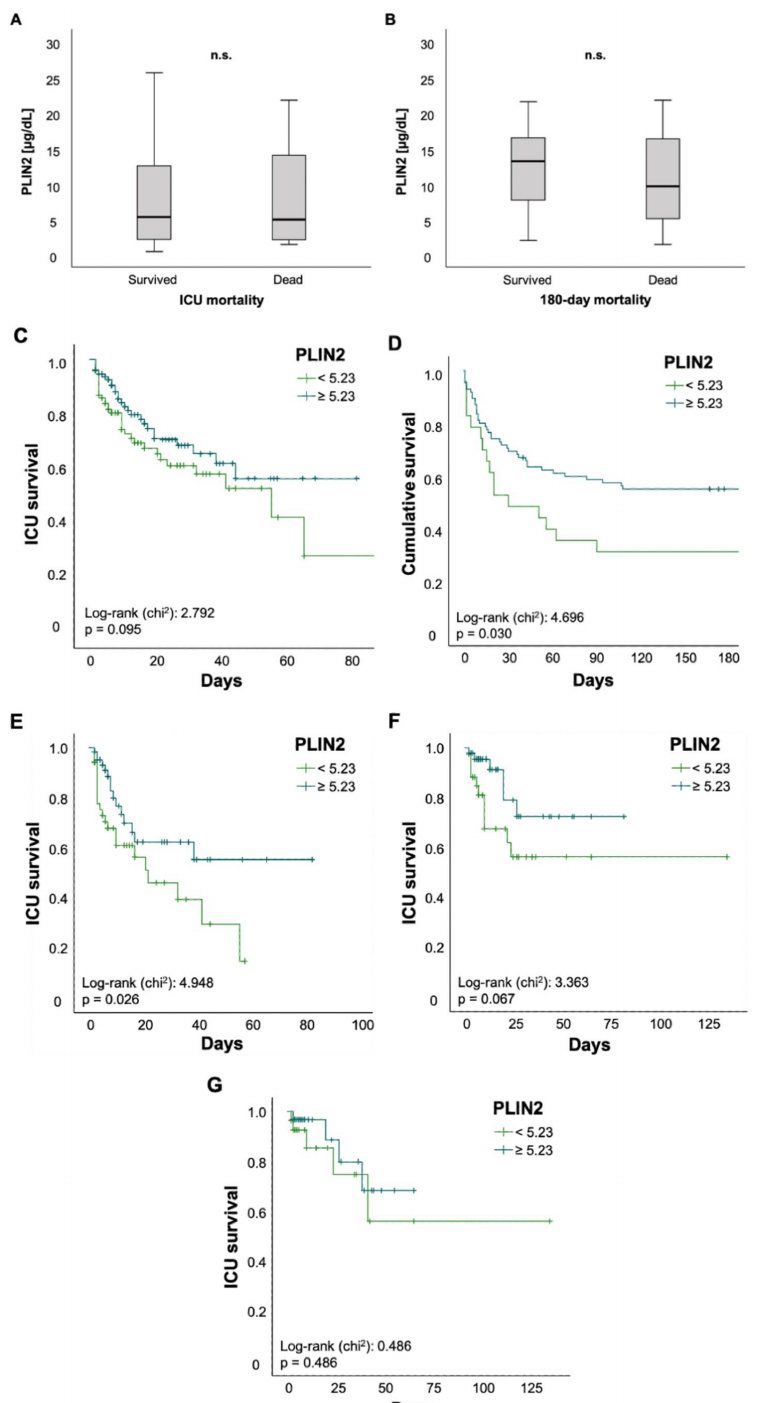
Figure 4. Serum concentrations of PLIN2 may predict ICU mortality in patients older than 65 years. ( A – G ) Neither total ICU- nor 180-day mortality was associated with significant changes in PLIN2 levels ( A , B ). Kaplan–Meier curve analysis showed a trend towards significancy for ICU mortality ( C ), whereas 180 day mortality was significant ( D ). Subgroup analysis revealed that reduced PLIN2 levels in patients older than 65 years may predict ICU mortality ( E ), whereas diabetic patients showed a trend towards significancy ( F ). PLIN2 was not able to predict mortality in patients with a body mass index above 30 ( G